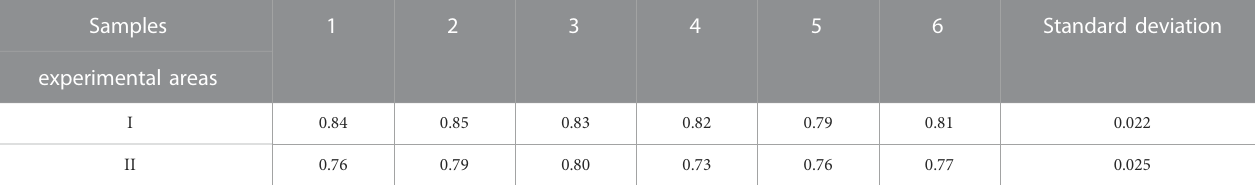
TABLE 8 Standard deviation based on CIA of each data in experimental area I and II. Samples experimental areas